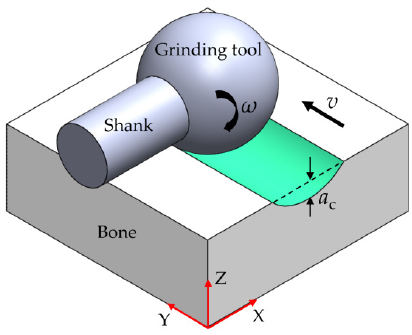
Figure 6. Schematic view of bone grinding process. Table 1. Grinding process parameters and their considered levels.